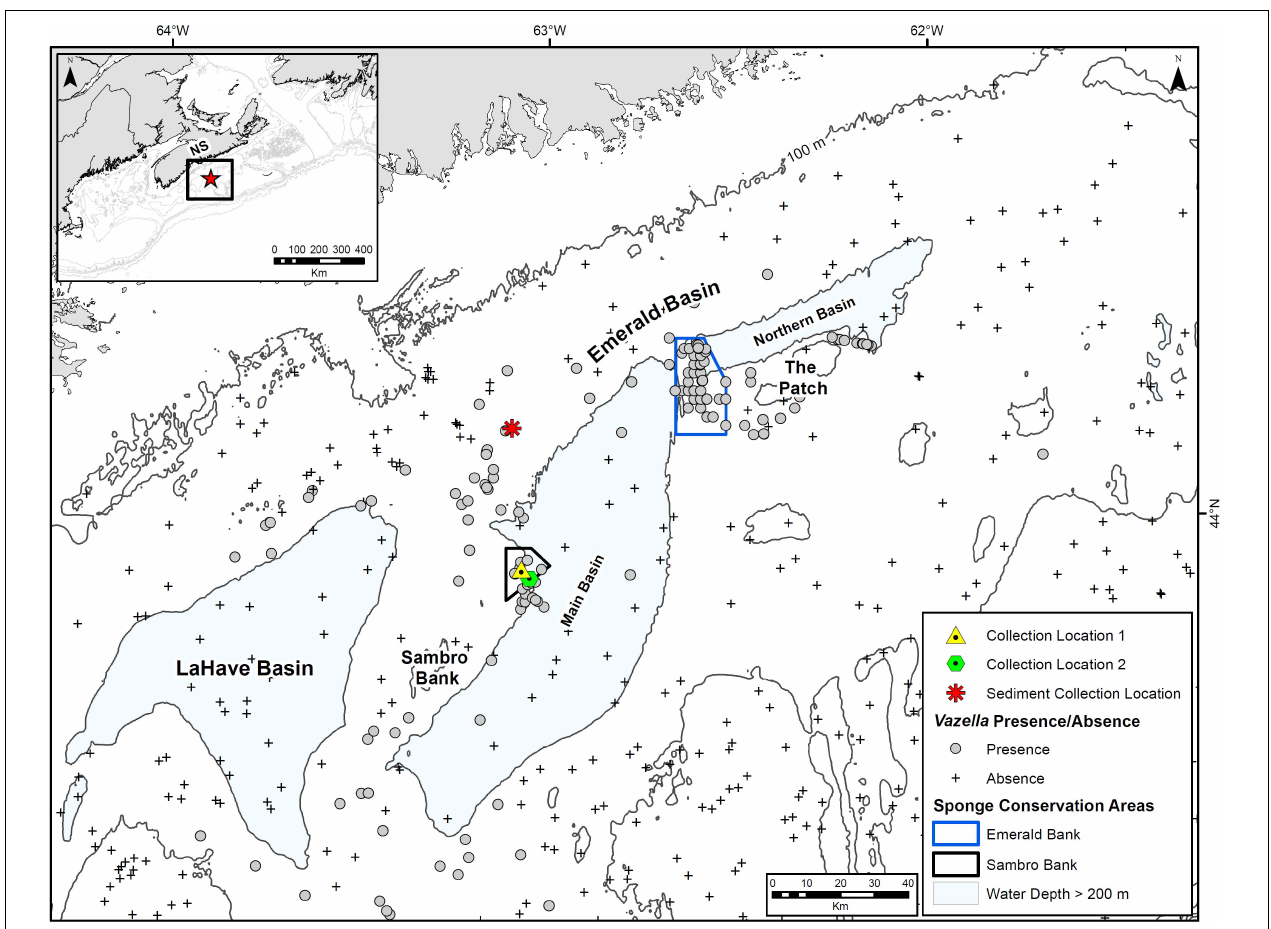
FIGURE 2 | Location of collection sites for ex situ experiments in the Sambro Bank Sponge Conservation Area, Emerald Basin, Nova Scotia. Also shown is the location of sediment collection north of Emerald Basin, and the presence–absence of Vazella pourtalesii from commercial bycatch records, and DFO optical (camera) and multispecies research vessel trawl